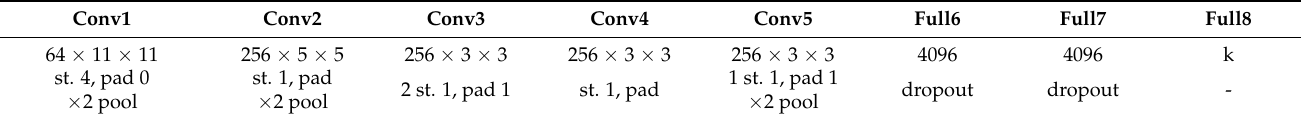
Table 2. Parameters of